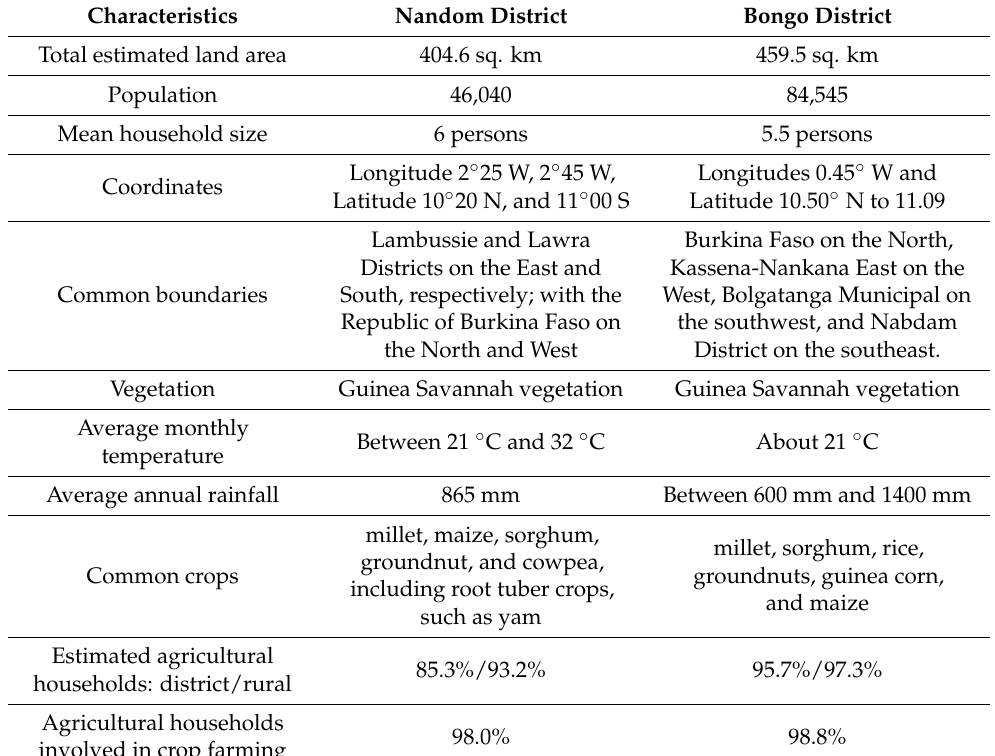
Table A1. A summarized description of the study